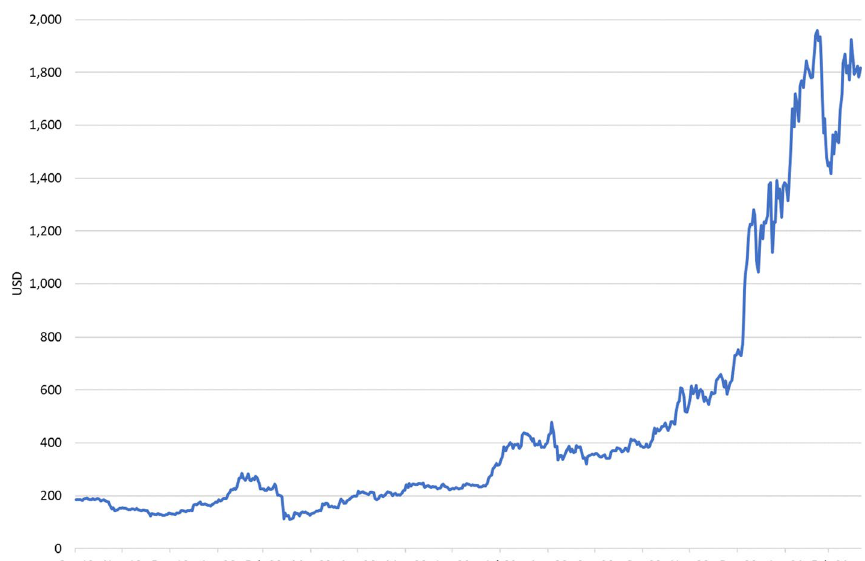
Fig. 10 Exchange rate ETH and USD. Source : Yahoo Finance